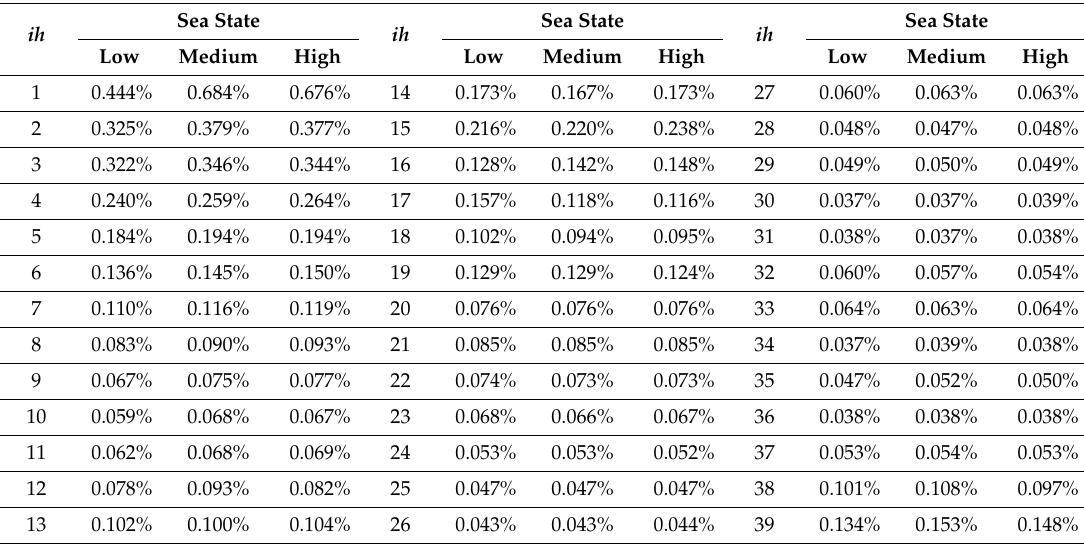
Sea trials average reportable ratios of harmonic current amplitudes for each resource